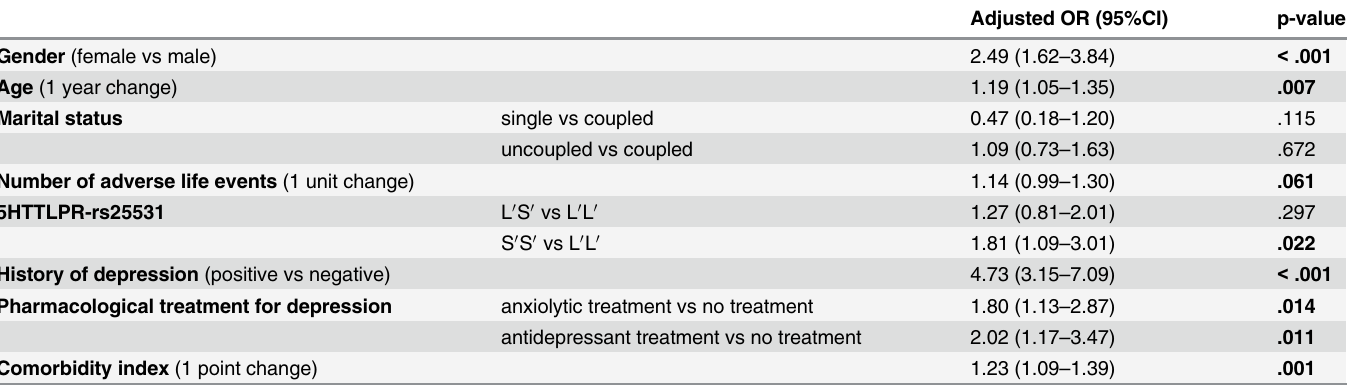
Table 2. Mutually adjusted associations of depressive symptoms * (relevant vs not relevant) with genotype, adverse life events, pharmacological treatment for depression, history of depression, marital status, comorbidity index, gender and age distribution. Adjusted odds ratios (OR adj ) with confidence intervals (95%CI) and p-values are reported^